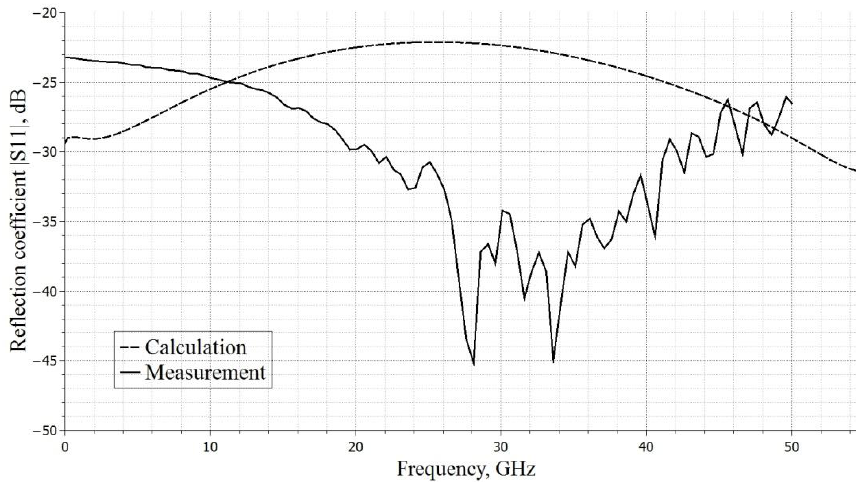
Fig. 5. Simulated vs measured S11.